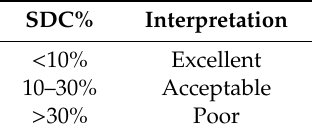
Table 5. Smallest Detectable Change (SDC) values interpretation [25,36].